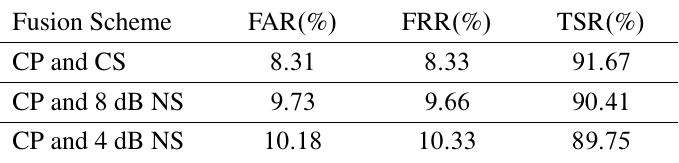
Table 4. Verification rate of match score level fusion of clean palmprint using PCA MM with speech (clean and